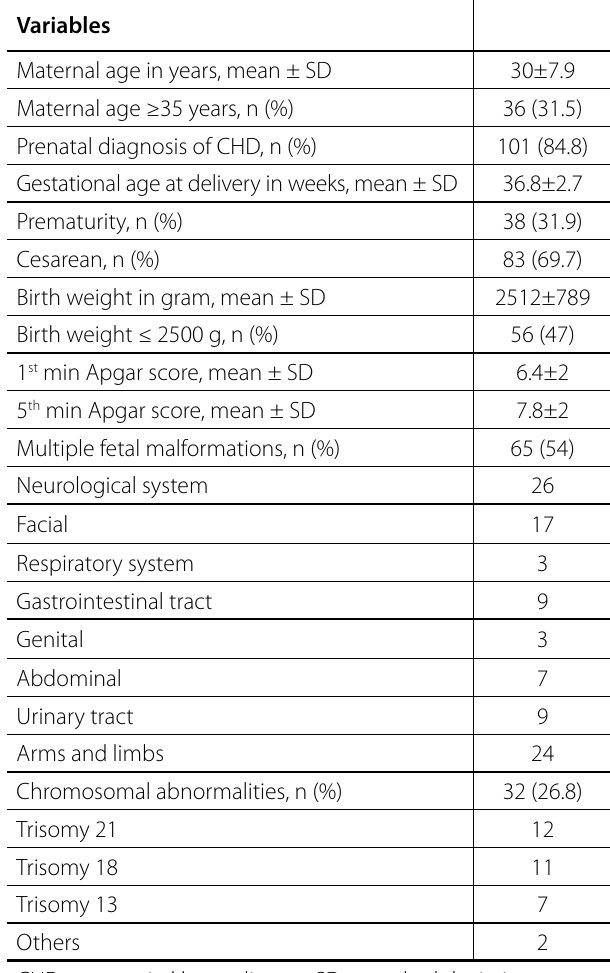
Table 1 . Baseline characteristics of patients